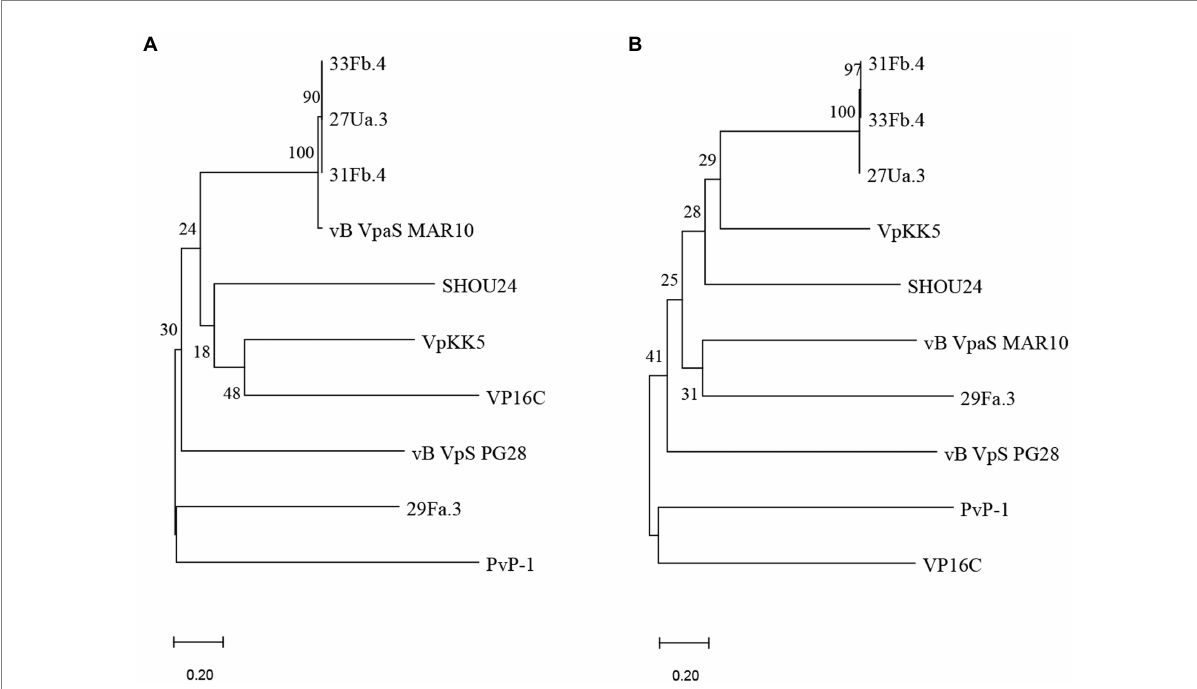
FIGURE 2 Phylogenetic trees based on the predicted major capsid (A) and major tail (B) proteins of the phages isolated in this study (27Ua.3, 29Fa.3, 31Fb.4, and 33Fb.4) and other publicly available Vibrio parahaemolyticus phages. Protein identities were predicted from ORFs or coding sequences using PhANNs, and analyzed using MEGA11: all putative amino acid sequences were aligned using MUSCLE and phylogenetic trees were constructed by neighbor-joining with 1,000 bootstrap replicates. Nodes are marked with the bootstrap value as